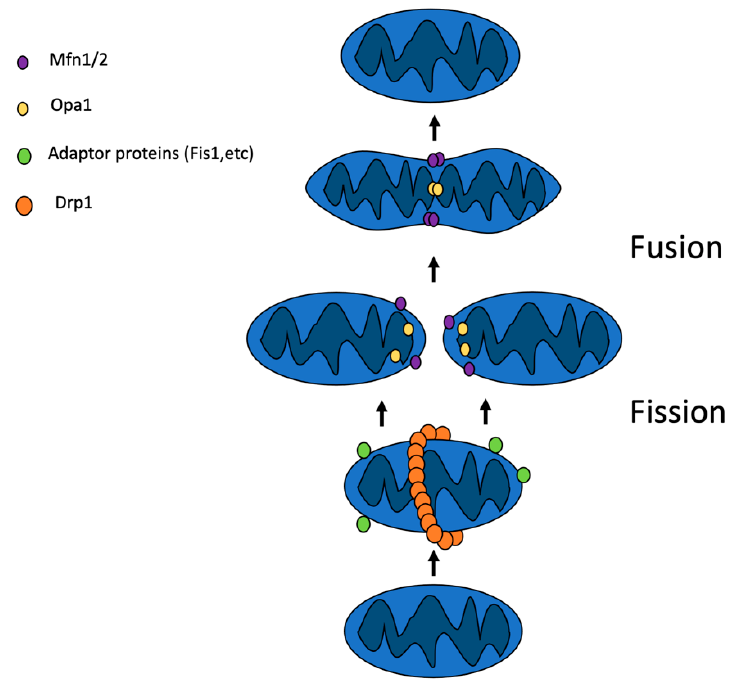
Figure 1. Mitochondrial dynamics. Fusion is controlled by Mfn1 (mitofusin1), Mfn2 (mitofusin 2), and Opa1 (optic atrophy protein 1); fission is mediated by Drp1 (dynamin-related protein 1), and adaptor proteins, such as Fis1 (mitochondrial fission protein 1), and others. Table 1. Proteins responsible for mitochondrial dynamic processes.